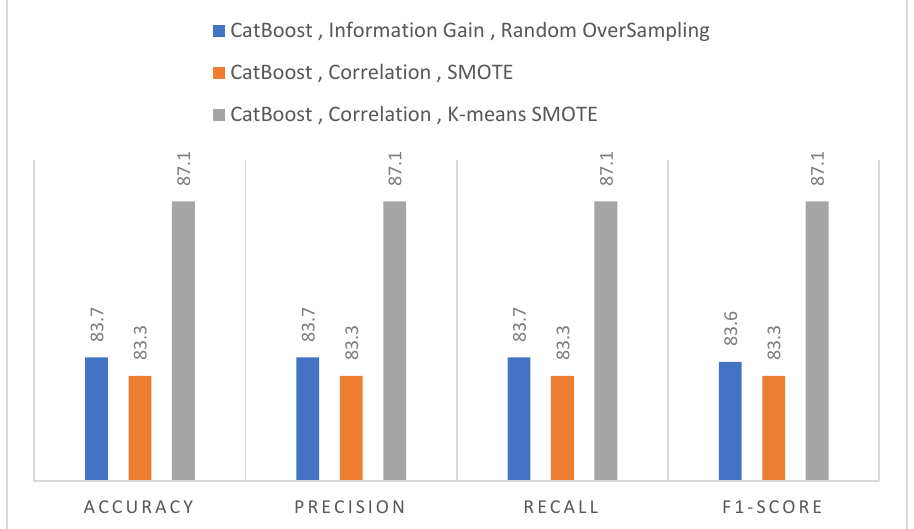
Figure 4. Result of CatBoost models to Oversampling and feature selection technique.